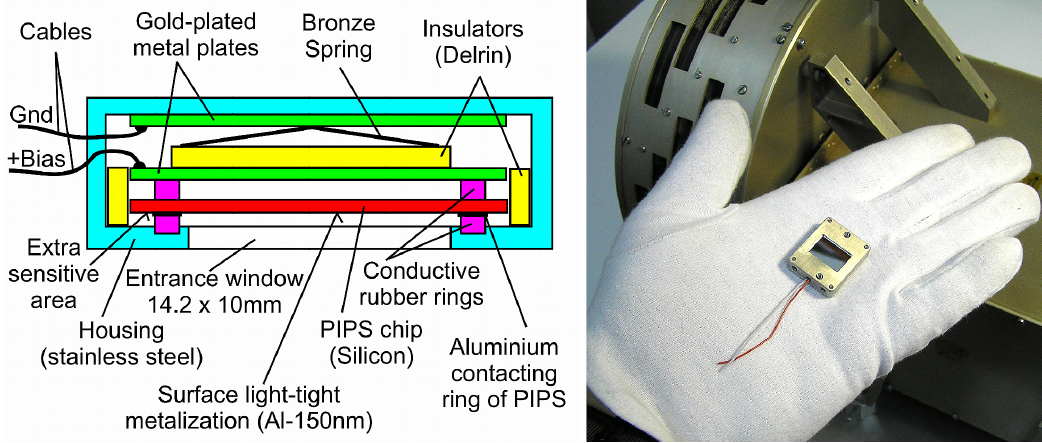
Fig. 3. (Left) sketch showing the internal structure of a PIPS detector; (right) view indicating the physical size of such a detector.